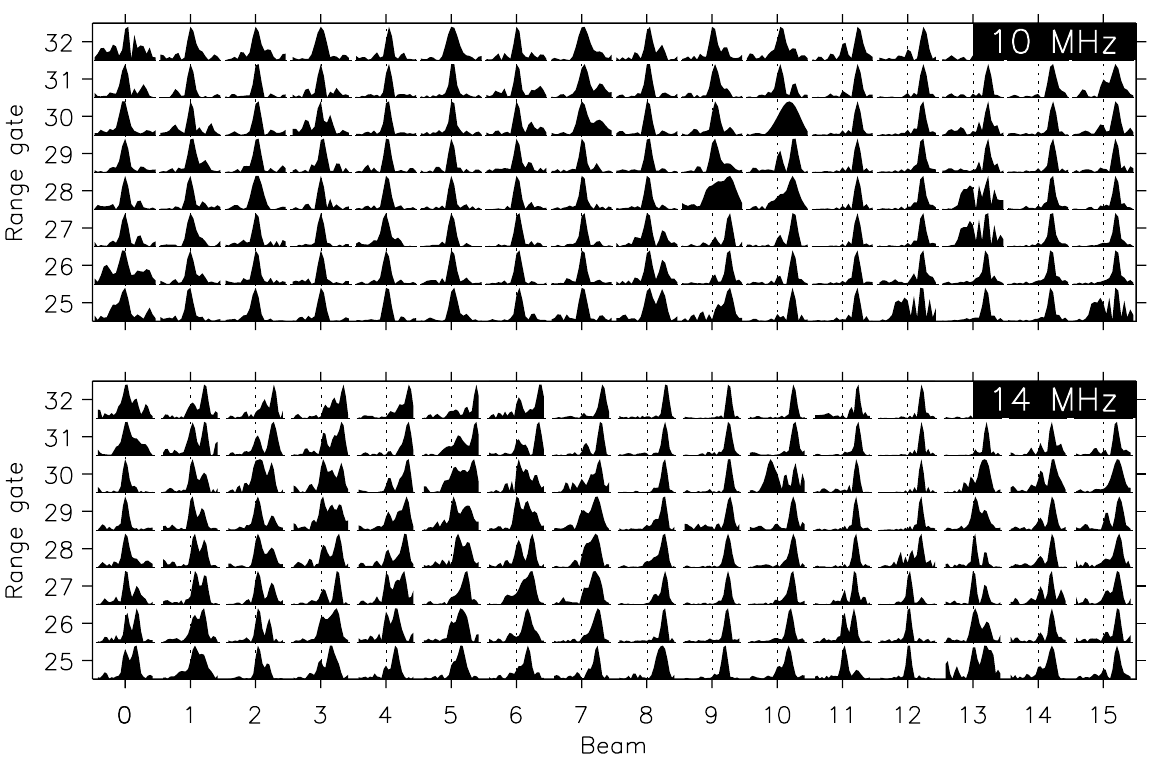
Fig. 11. Doppler spectra of echoes observed on channel A (top panel) and B (bottom panel) for the scan starting 18:44:57UT, as shown at the top of Fig. 9. Each spectrum is shown self-normalized, in the velocity range ± 1000ms − 1 .